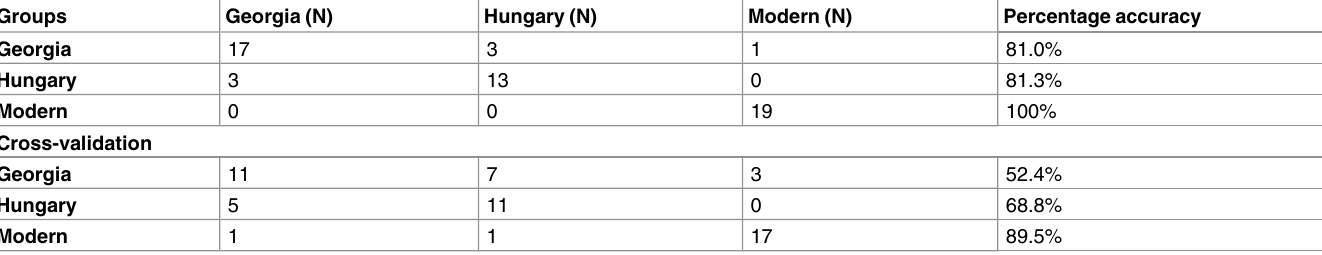
Table 2. Classification accuracyfrom discriminant analysis of cranial outline.